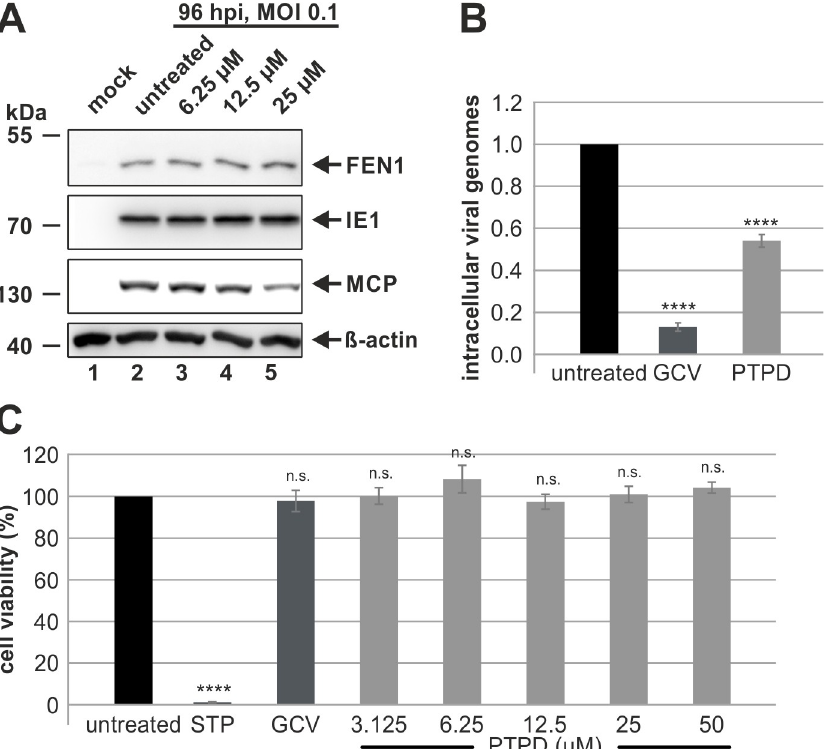
Fig 6. Requirement of FEN1’s enzymatic activity for viral DNA replication. (A) HFFs were infected with AD169 at an MOI of 0.1 or left uninfected (mock) and, at 2 hpi, treated either with DMSO or with different concentrations PTPD. At 96 hpi, cells were harvested and analyzed by Western blotting for FEN1, IE1, MCP, and β -actin. (B) HFFs were infected with AD169 at an MOI of 0.1 and, at 2 hpi, treated with the FEN1 inhibitor PTPD (25 μ M), ganciclovir (GCV) (20 μ M) or left untreated. At 96 hpi, total DNA was extracted, viral genomes were quantified by TaqMan real- time PCR specific for IE1, and genome copy numbers were calculated. Untreated cells were set to 1. Values are derived from biological triplicates and represent mean values ± SD. (C) Cell viability measured after a 96 h treatment of HFFs with the positive control Staurosporin (STP) (5 μ M), ganciclovir (GCV) (20 μ M) and PTPD (concentrations as indicated). Untreated cells were set to 100%. Values are derived from biological triplicates and represent mean values ± SD. For panels B and C, the p-values were calculated using two-tailed Student’s t-tests. n.s., not significant; ���� , p �